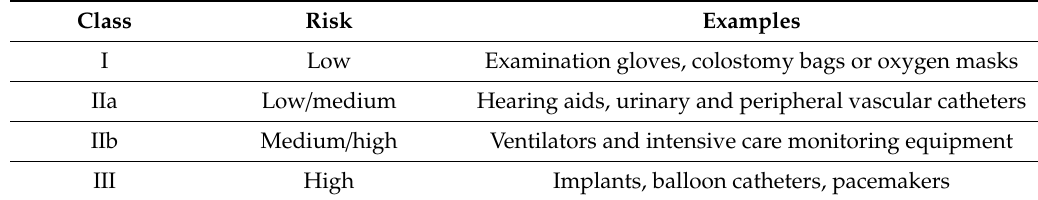
Table 1. Risk classification and related examples of medical